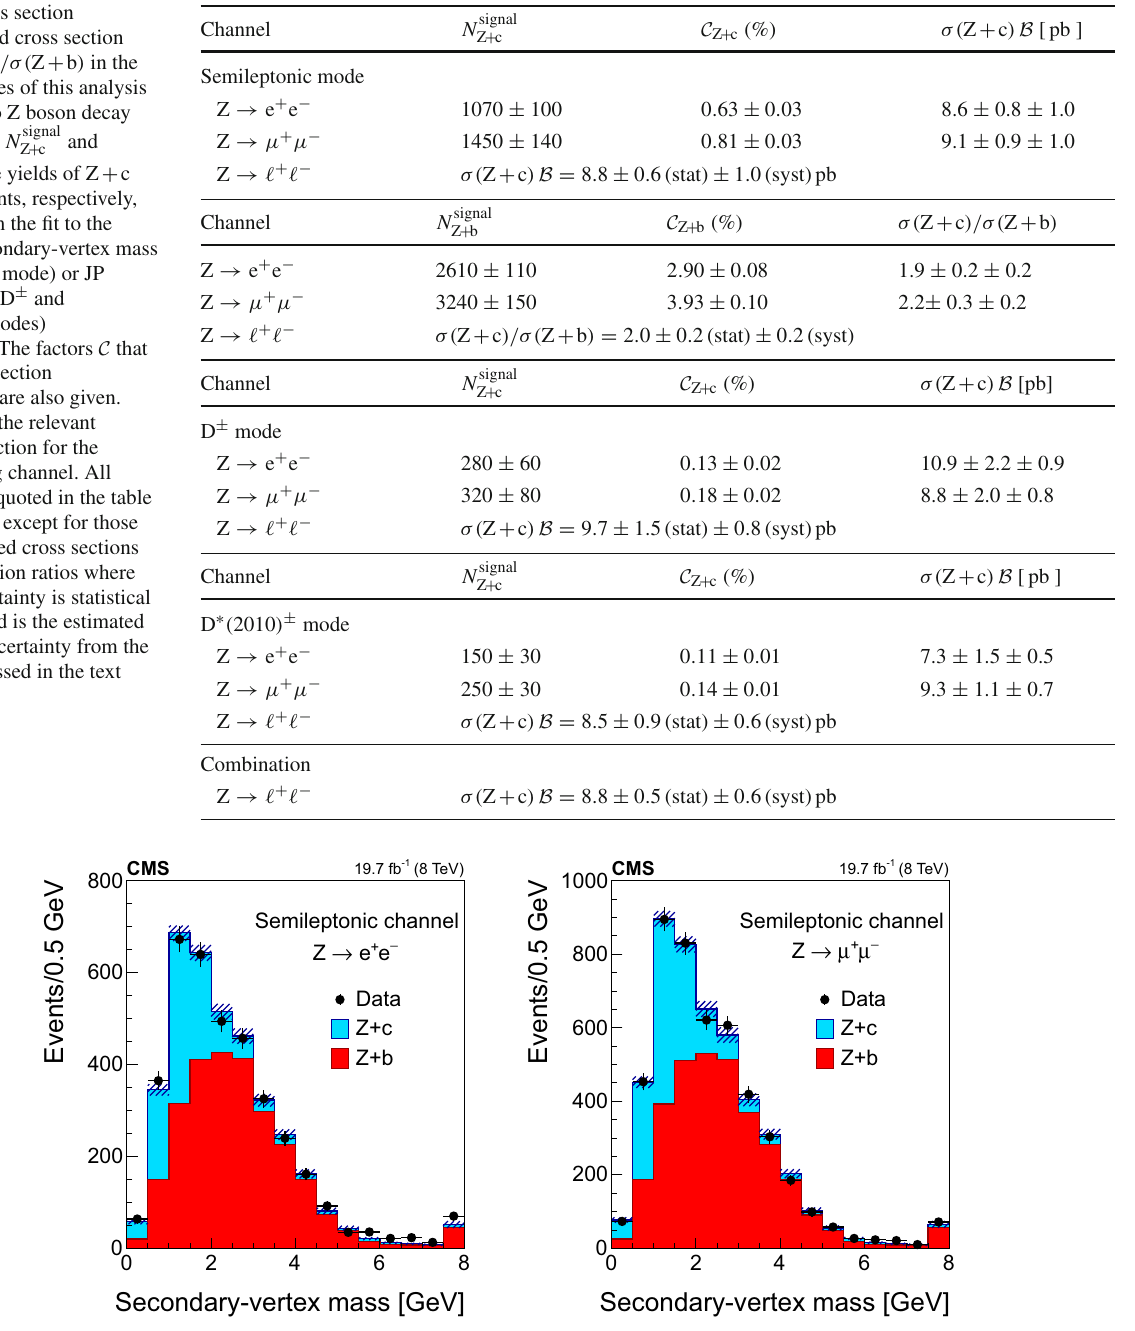
Fig. 7 Corrected secondary-vertex mass distributions, after back- ground subtraction, in the dielectron (left) and dimuon (right) channels for events selected in the semileptonic mode. Events with M corr vertex > 8GeV are included in the last bin of the distribution. The shape of the Z + c and Z + b contributions is estimated as explained in the text.